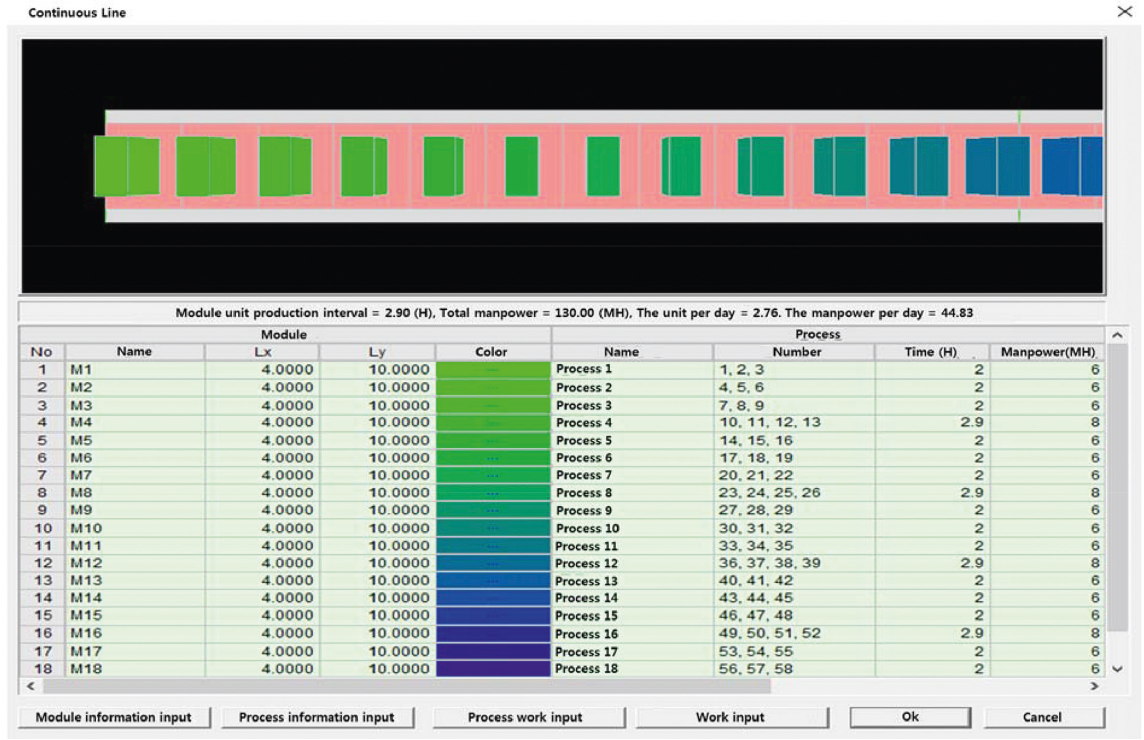
Figure 7: Manufacturing line with process code, process name, and time for continuous production line.